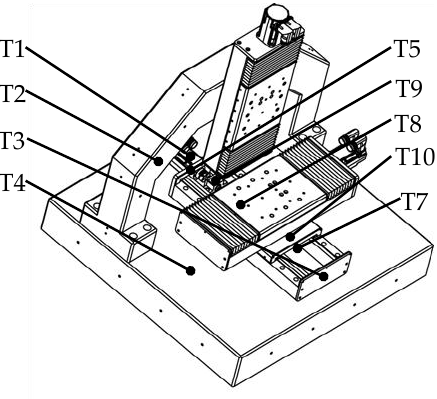
Figure 5. Measurement set-up.